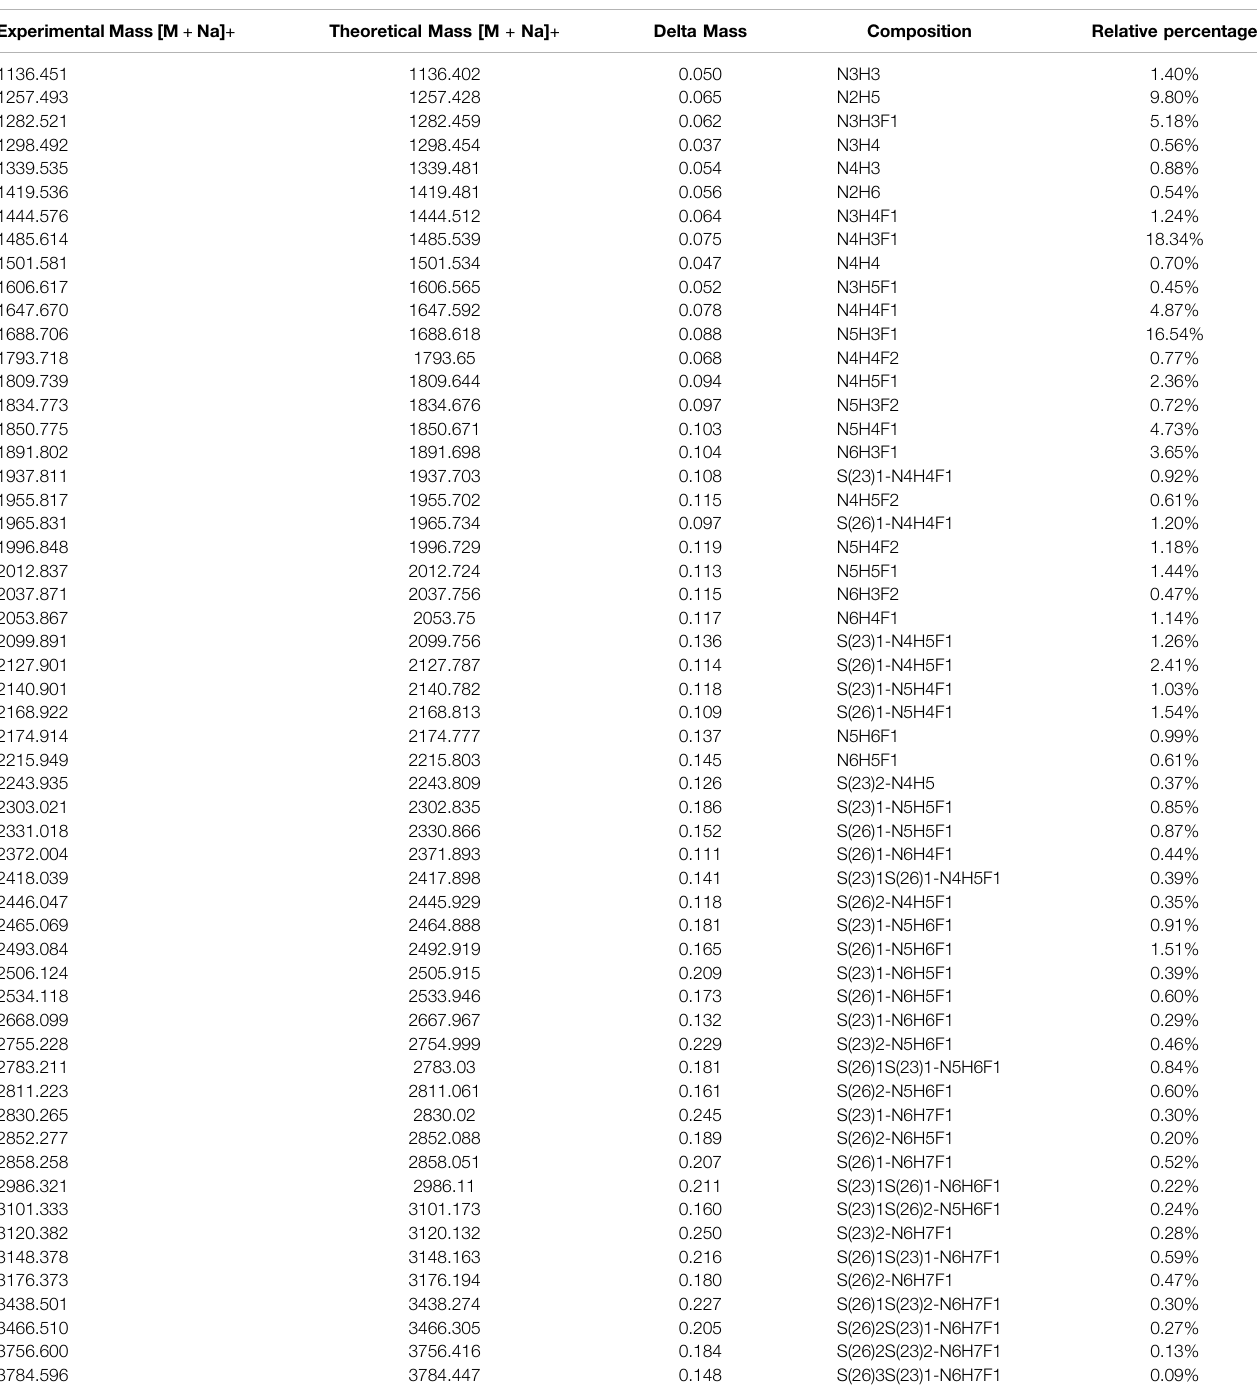
TABLE 2 | Released N-glycans identi fi ed from HEK-Spike protein. Experimental Mass [M + Na]